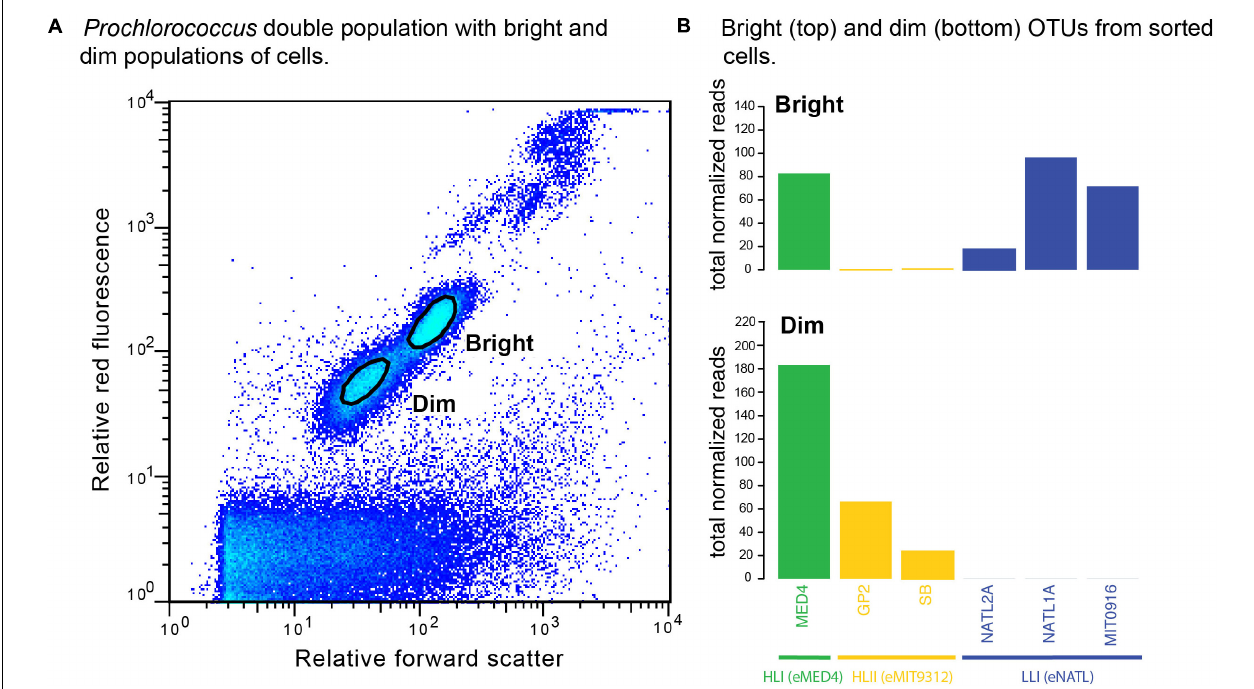
FIGURE 4 | Ecotype identity of cells from Prochlorococcus double populations. (A) “Bright” and “dim” populations were defined based on relative red fluorescence and relative forward scatter signals. The boundary of sort gates is indicated by black ovals. “Bright” cells (B top) were composed of low-light adapted ecotypes (blue) and high-light adapted ecotypes (green and yellow). “Dim” cells (B bottom) were composed solely of high-light adapted ecotypes (green and